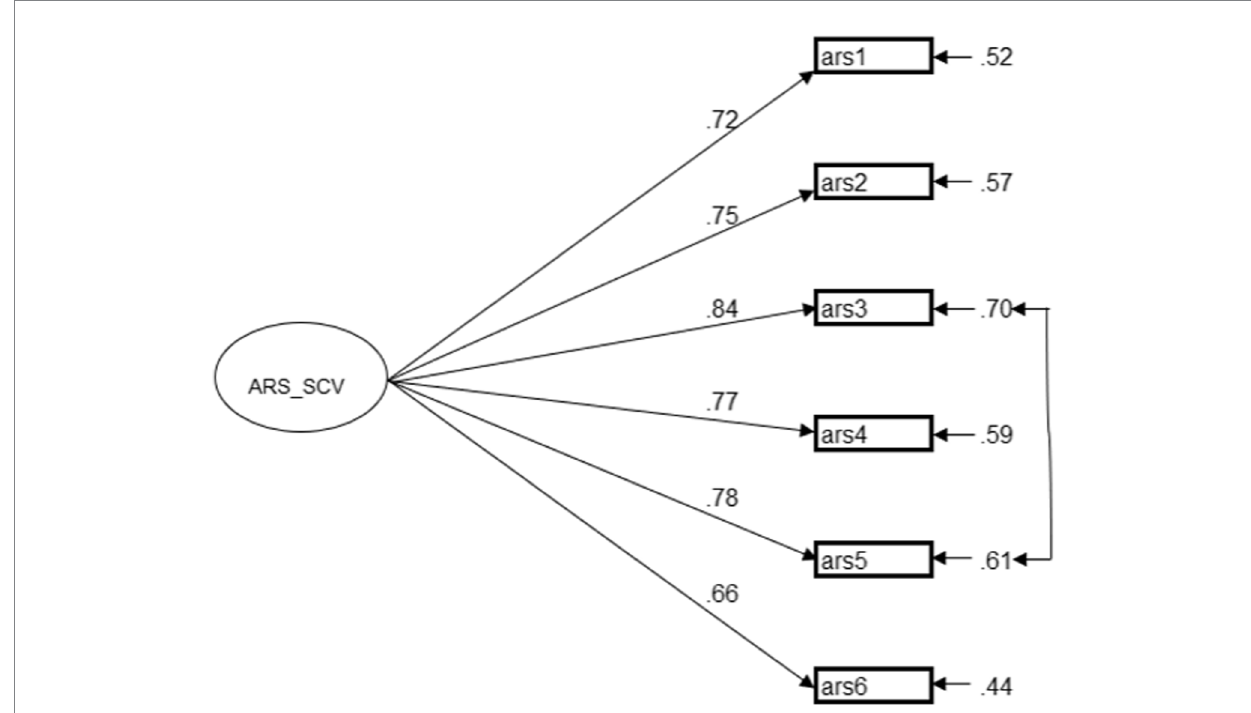
FIGURE 2 First-order model structure of ARS-SCV. All modeled correlations and path coefficients are standardized and significant at p < 0.001.